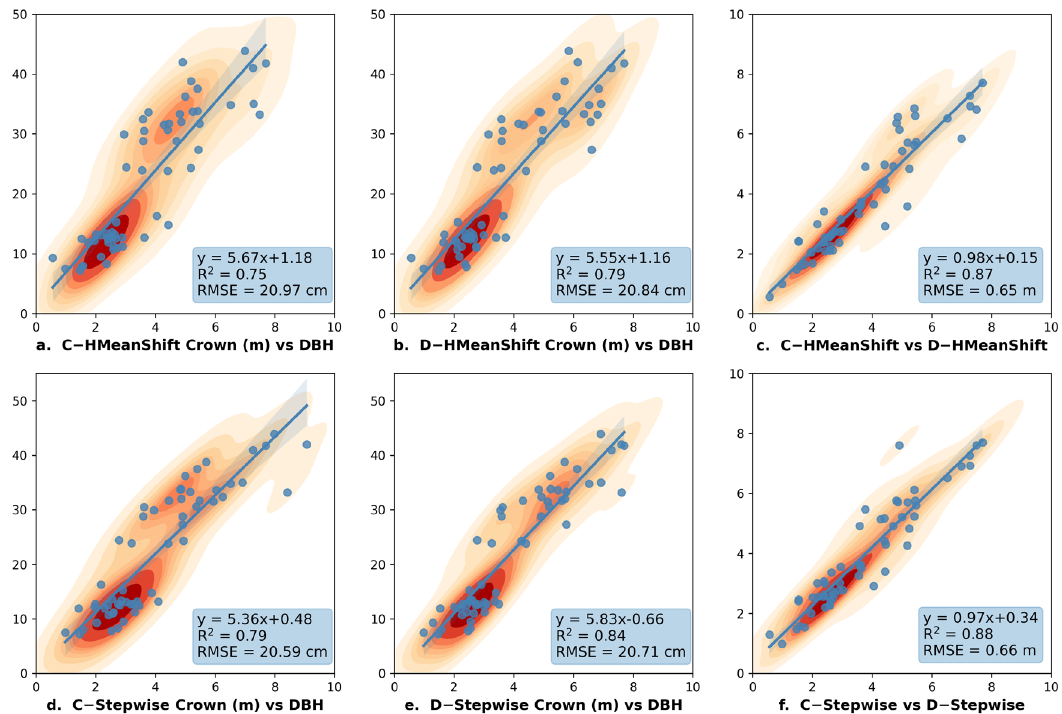
Figure 6. Correlations with the heatmap in estimation of the crown size between field measured DBH and the designed approaches. Lines are regression lines with a 95% confidence interval; the blue boxes include the regression line expression, R-squared, and RMSE.